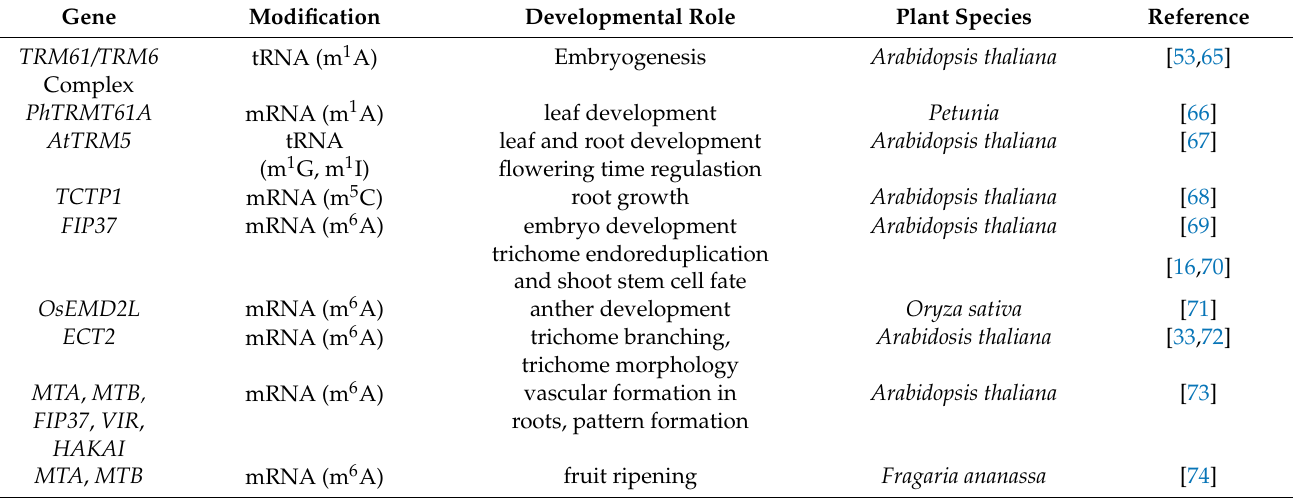
Table 1. Role of post-transcriptional modifications in plants’ growth and